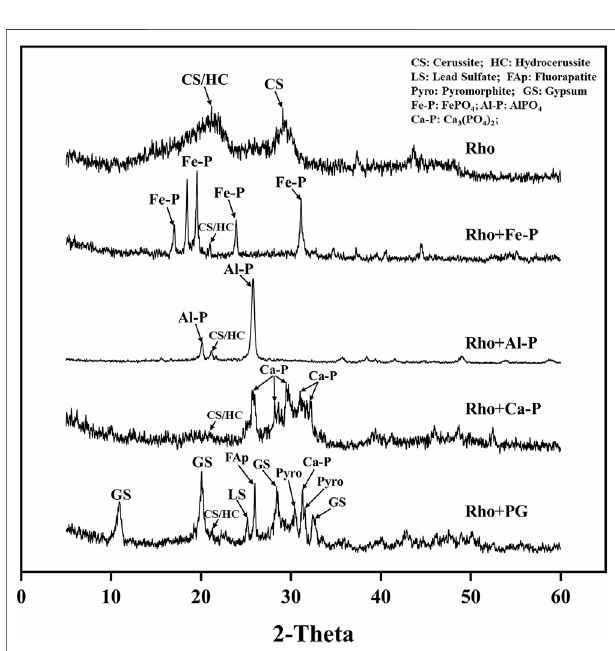
FIGURE 5 | XRD patterns of precipitation in each treatment after 6 days of